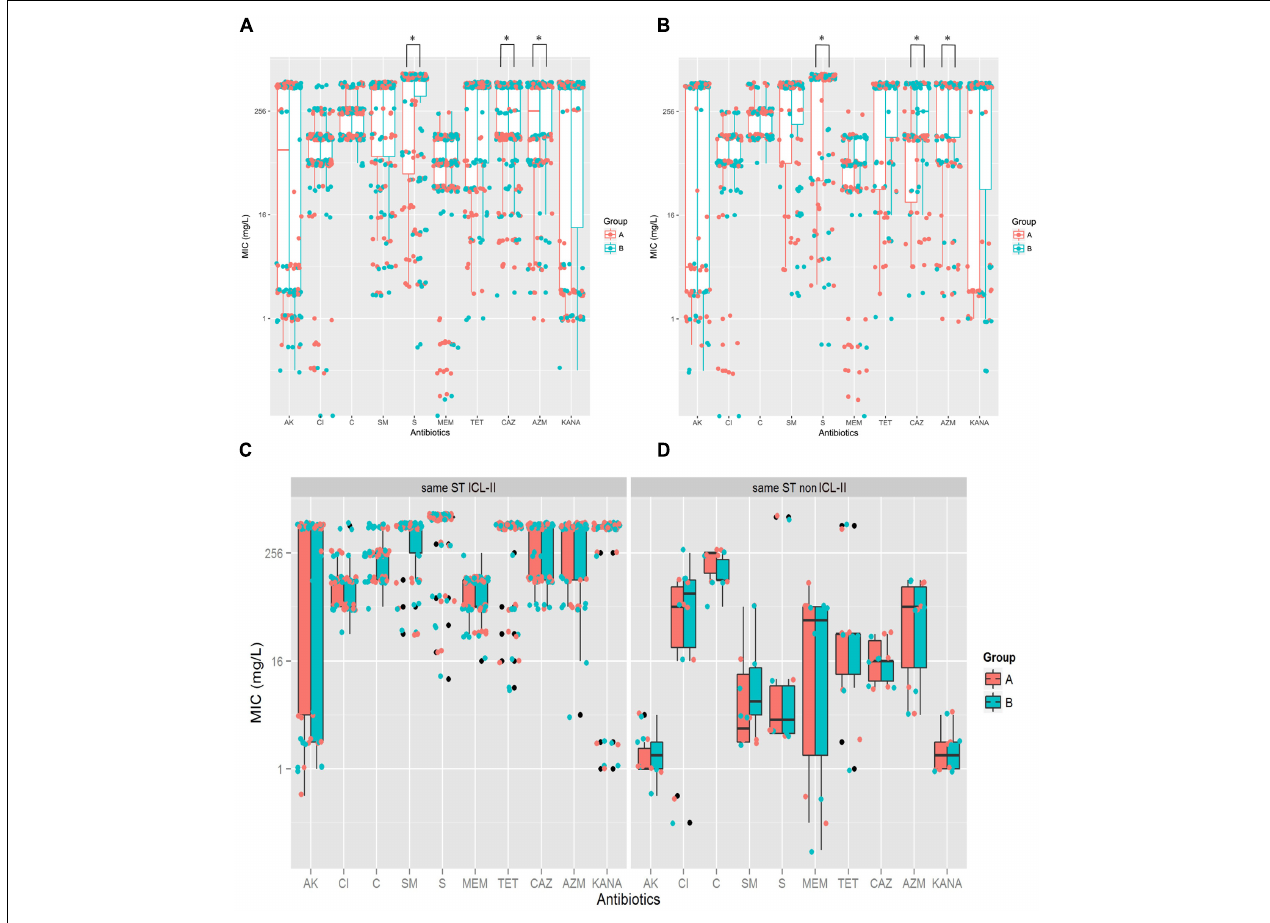
FIGURE 2 | A. baumannii exhibited more resistance after within-host evolution, among the isolates, ICL-II strain demonstrated more resistance than non-ICL-II strains did. (A) . For total sample, boxplots for Groups A and B showing the mean ratio of MIC for CAZ between Groups A and B. Dots indicate the detailed MIC values ratio for CAZ. (B) For the isolate pairs harboring different STs, boxplots for Groups A and B showing the mean ratio of MIC for AK, CAZ, MEM, and AZM between Groups A and B. Dots indicate the detailed MIC values ratio for that antibiotic. (C) MIC distributions for 10 antibiotics in whole genome-sequenced A. baumannii isolate pairs harboring the same ICL-II STs. Colors indicate the isolate in Groups A and B. Boxplots for each group indicate the mean MICs against the respective antibiotic. Dots indicate the detailed MIC value for that antibiotic. (D) MIC distribution for 10 antibiotics in all genome-sequenced A. baumannii isolate pairs harboring the same non-ICL-II